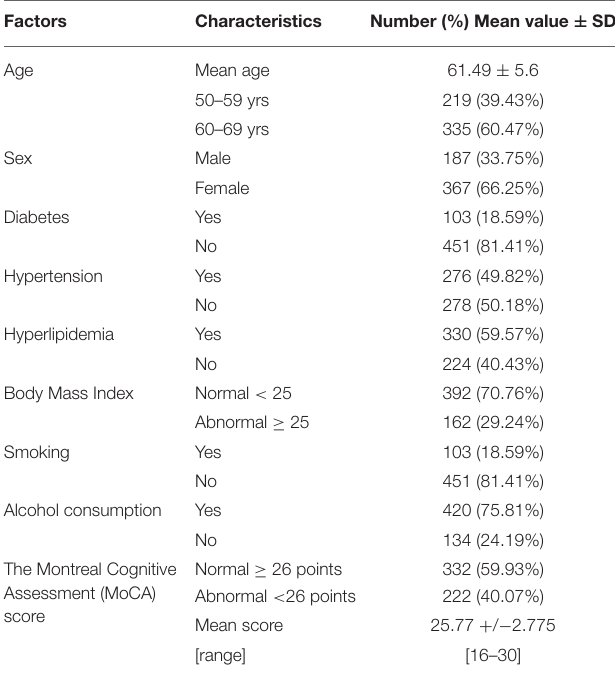
TABLE 1 | Characteristics of the study